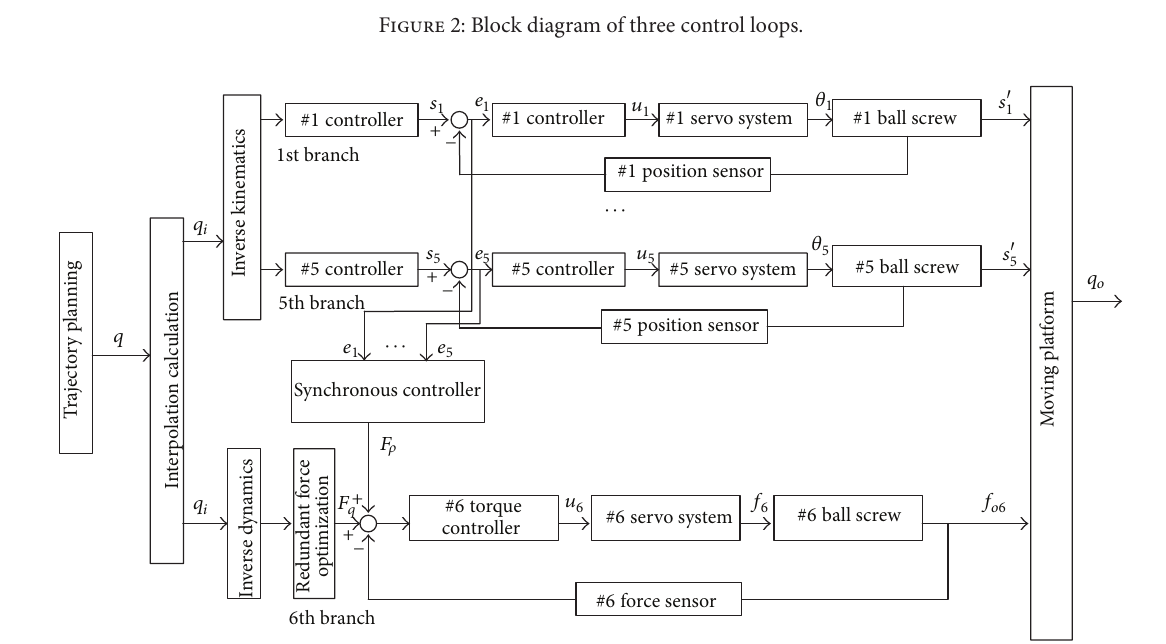
Figure 3: Force/position hybrid